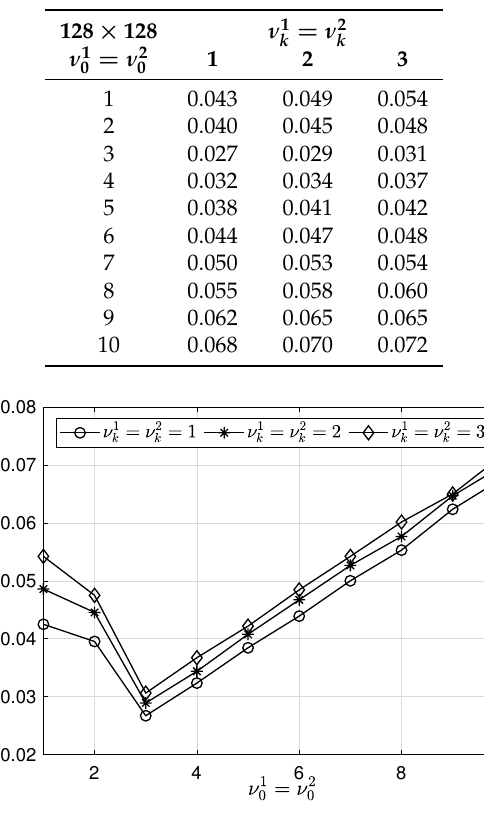
, ν 2 ) and fixed 0 0